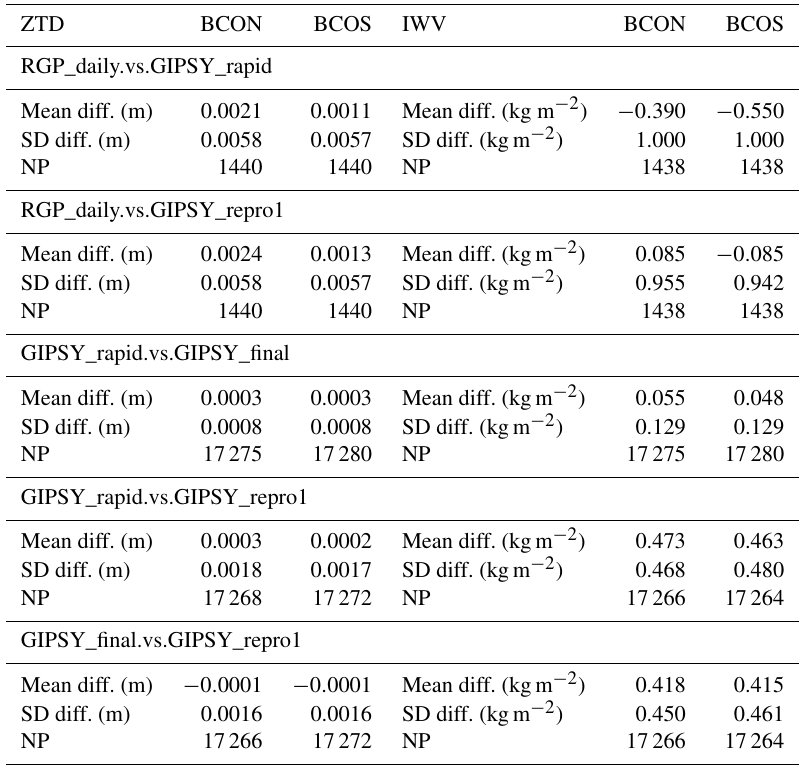
Table 3. Similar to Table 2 but for RGP daily, GIPSY rapid, and GIPSY repro1 results for stations BCON and BCOS. The leftmost part shows ZTD results and the rightmost shows IWV